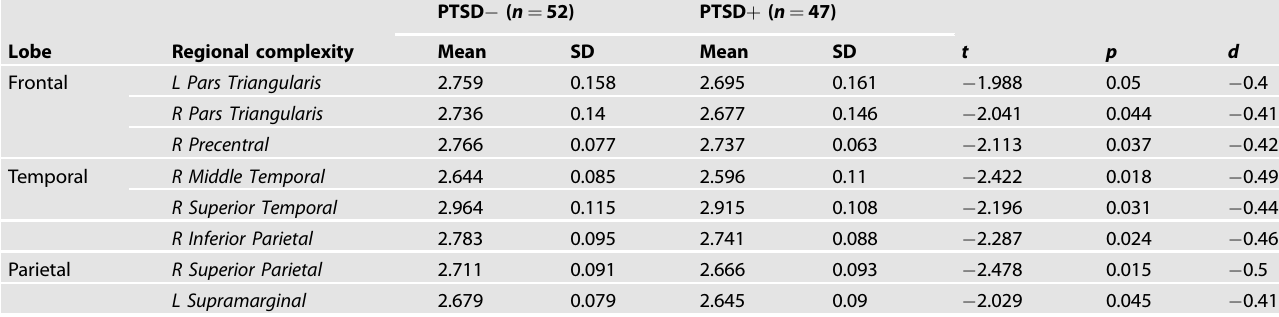
Table 2. Pairwise comparisons of regional fractal dimension (FD) cortical complexity using independent samples t -test with Welch ’ s correction between WTC responders with/without